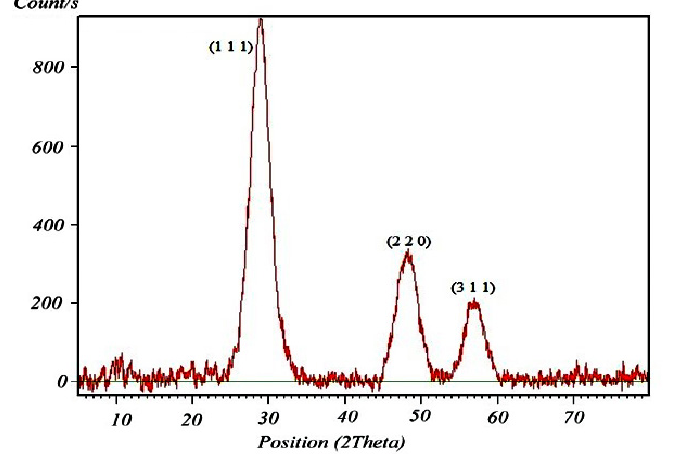
Fig. 1. XRD patterns of ZnS nanoparticles